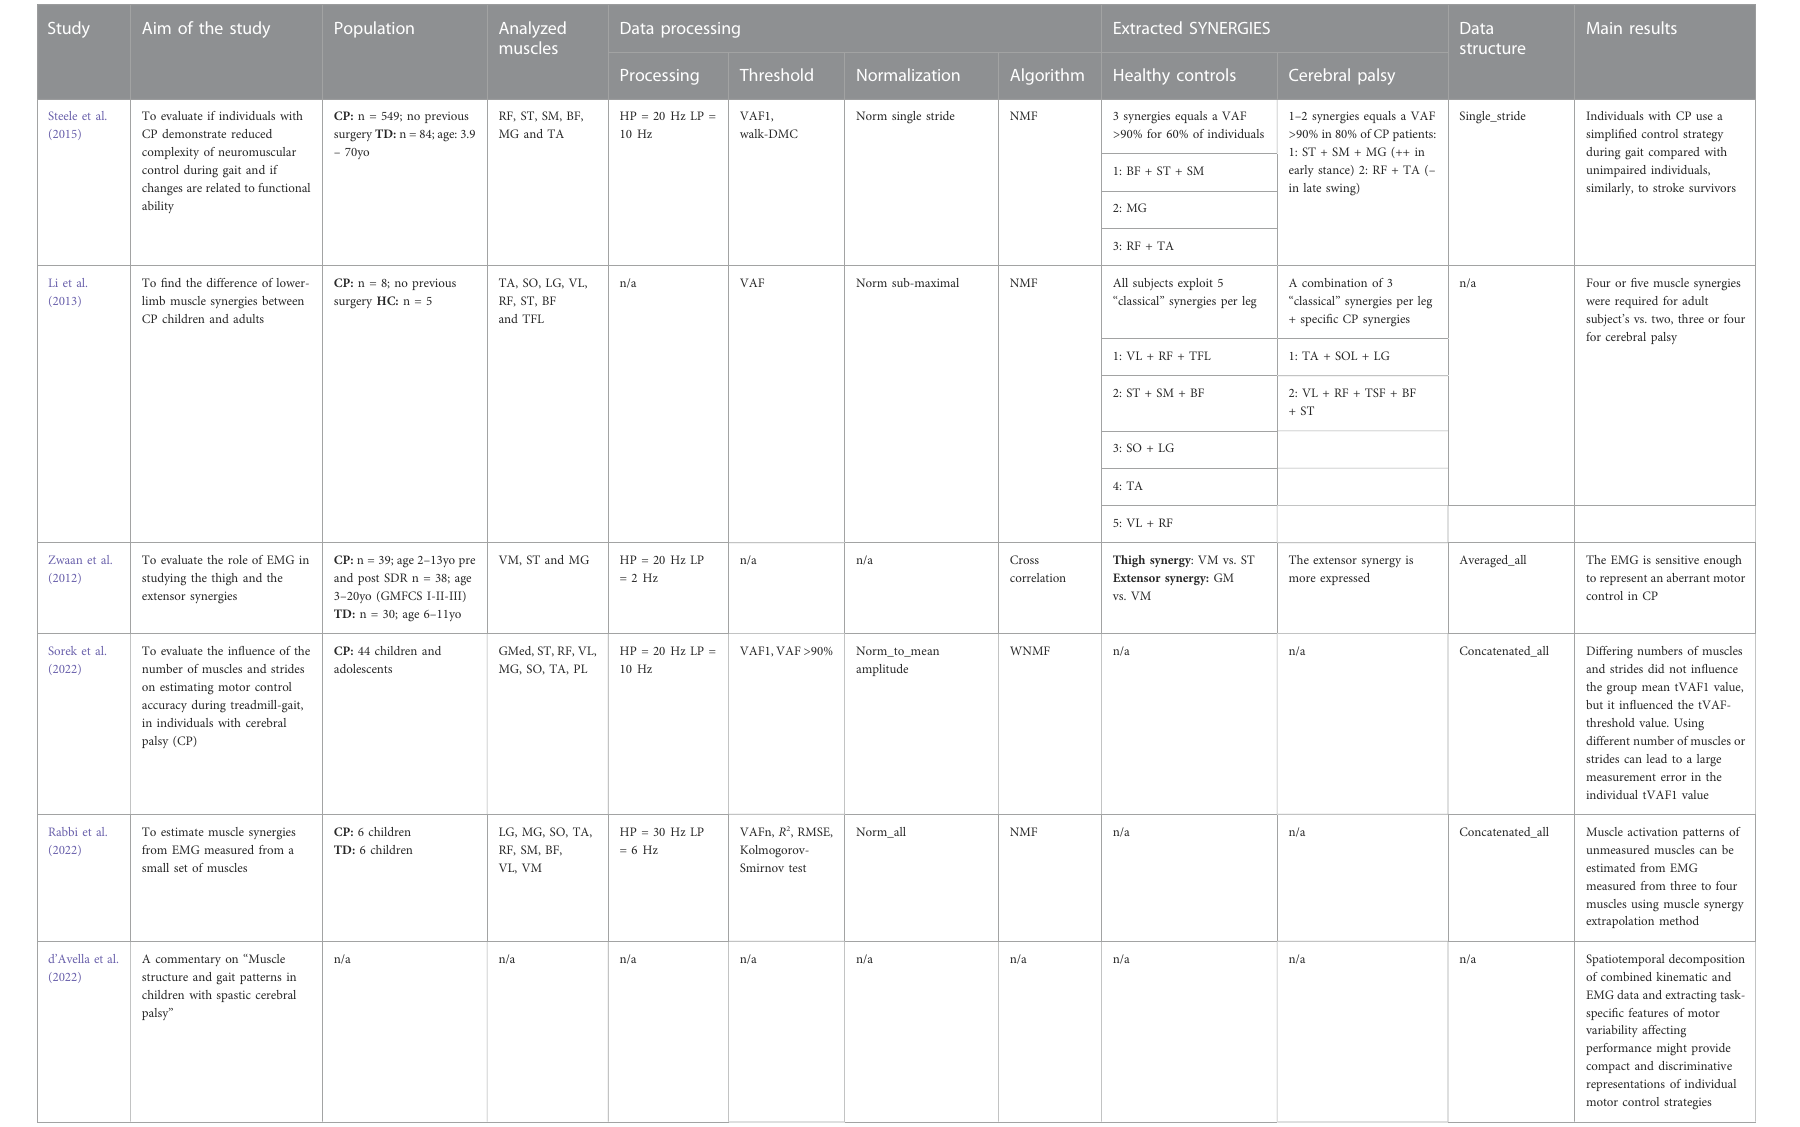
Thigh synergy : VM vs. ST Extensor synergy: GM vs.